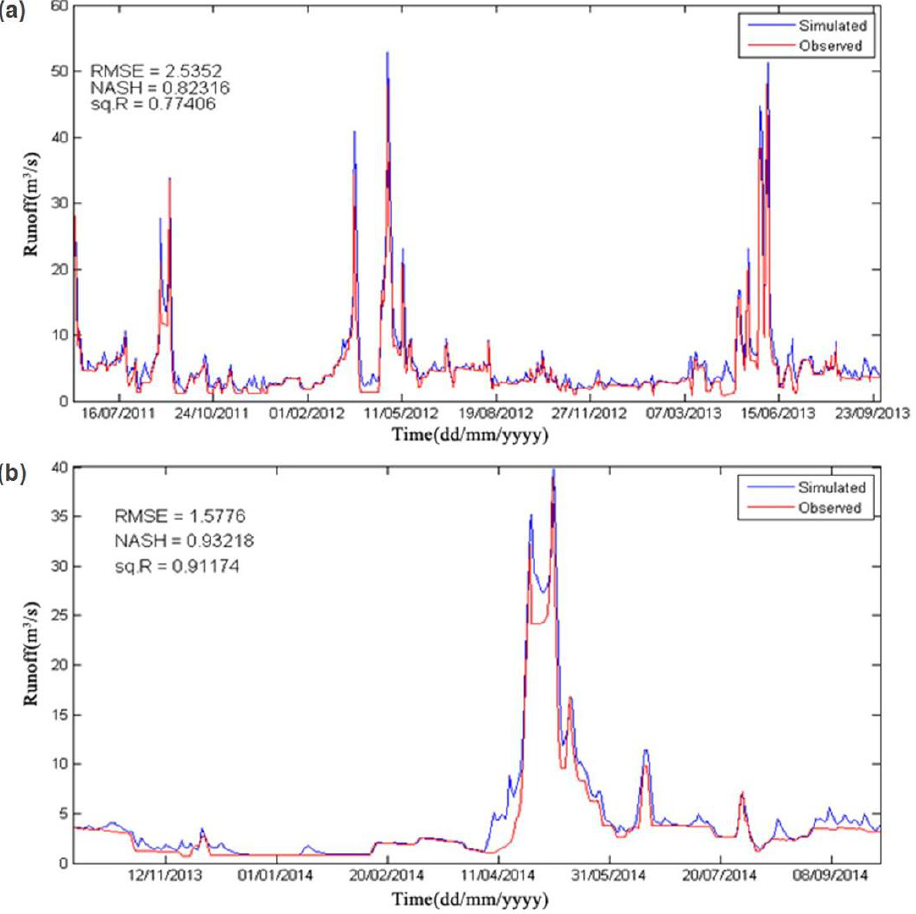
Figure 4. Observed and simulated flows with CEQUEAU hydrological model: ( a ) calibration (June 2011 to September 2013); and ( b ) validation periods (October 2013 to September 2014). Figure 5 shows observed and simulated daily water temperatures for the calibration and validation periods. Again, the model provided good results, with Nash coefficients above 0.9, RMSEs below 0.81. A systematic bias is observed during the calibration period and is exacerbated during the validation period, reaching −1.1 °C. This bias indicates that underestimation of the warmer temperatures in July and August by the model is likely.